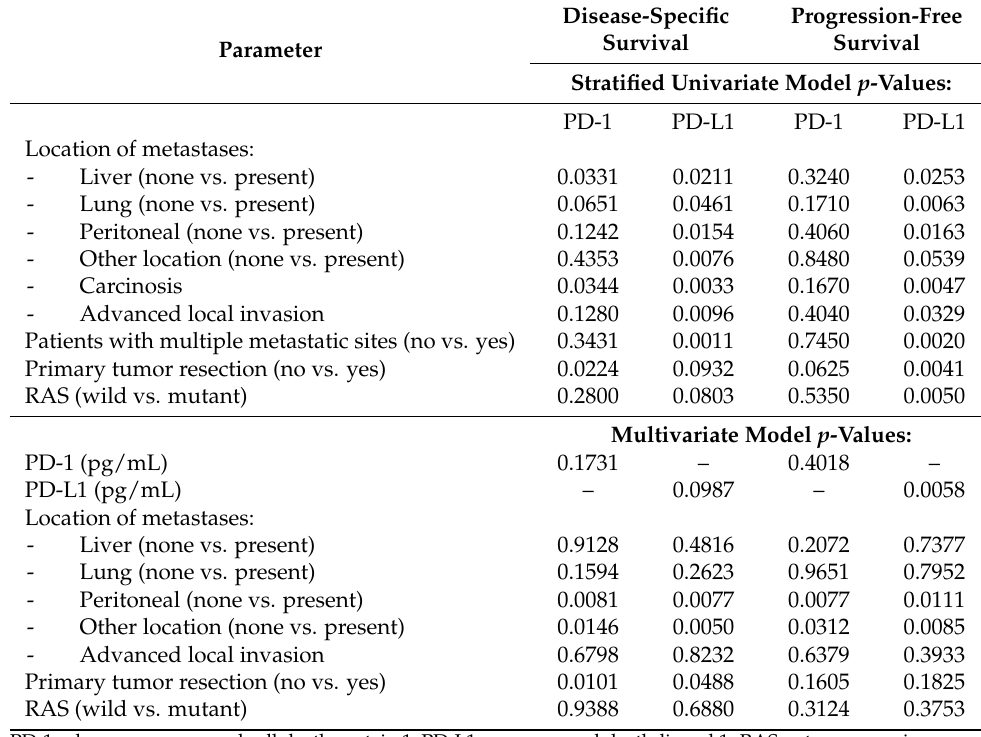
Table 3. The p -values obtained for survival models investigating the effect of tumor burden on PD-1 and PD-L1. Disease-Specific Survival Parameter